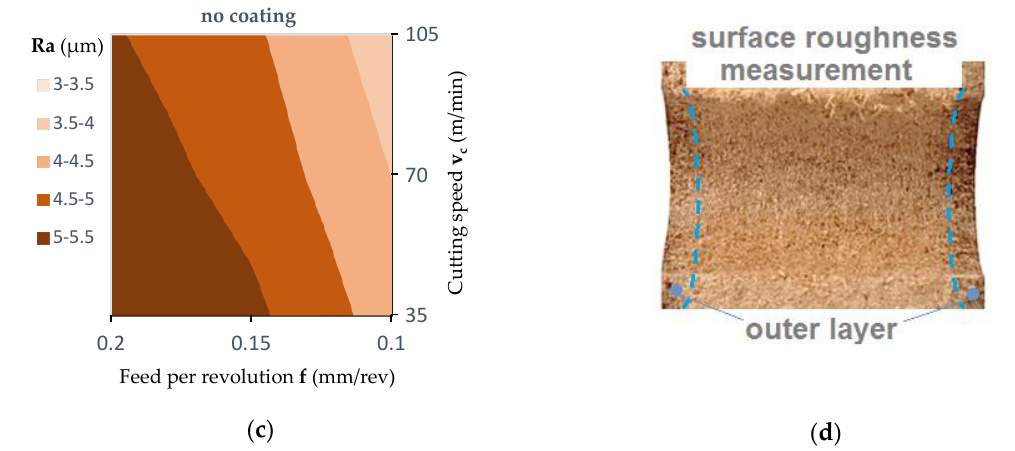
Figure 18. Influence of the feed value on the value of the surface roughness in the outer layer (contour diagrams): ( a ) For a TiAlN coated drill; ( b ) for a ZrN coated drill; ( c ) for an uncoated drill; ( d ) measurement area.